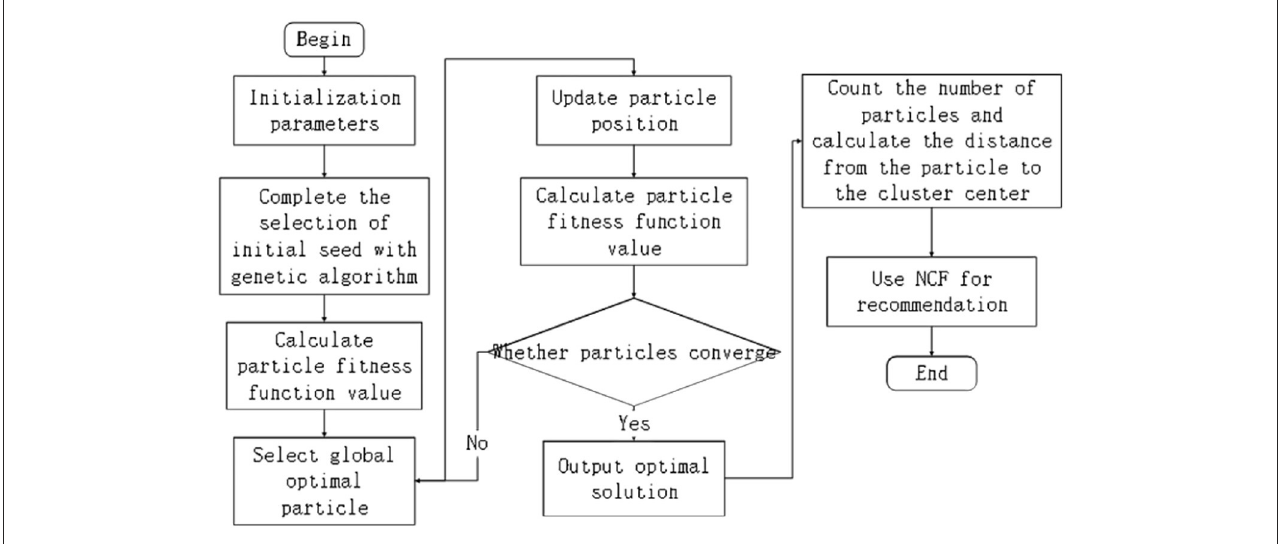
FIGURE1 Flowchart of PSO-based clustering recommendation algorithm.